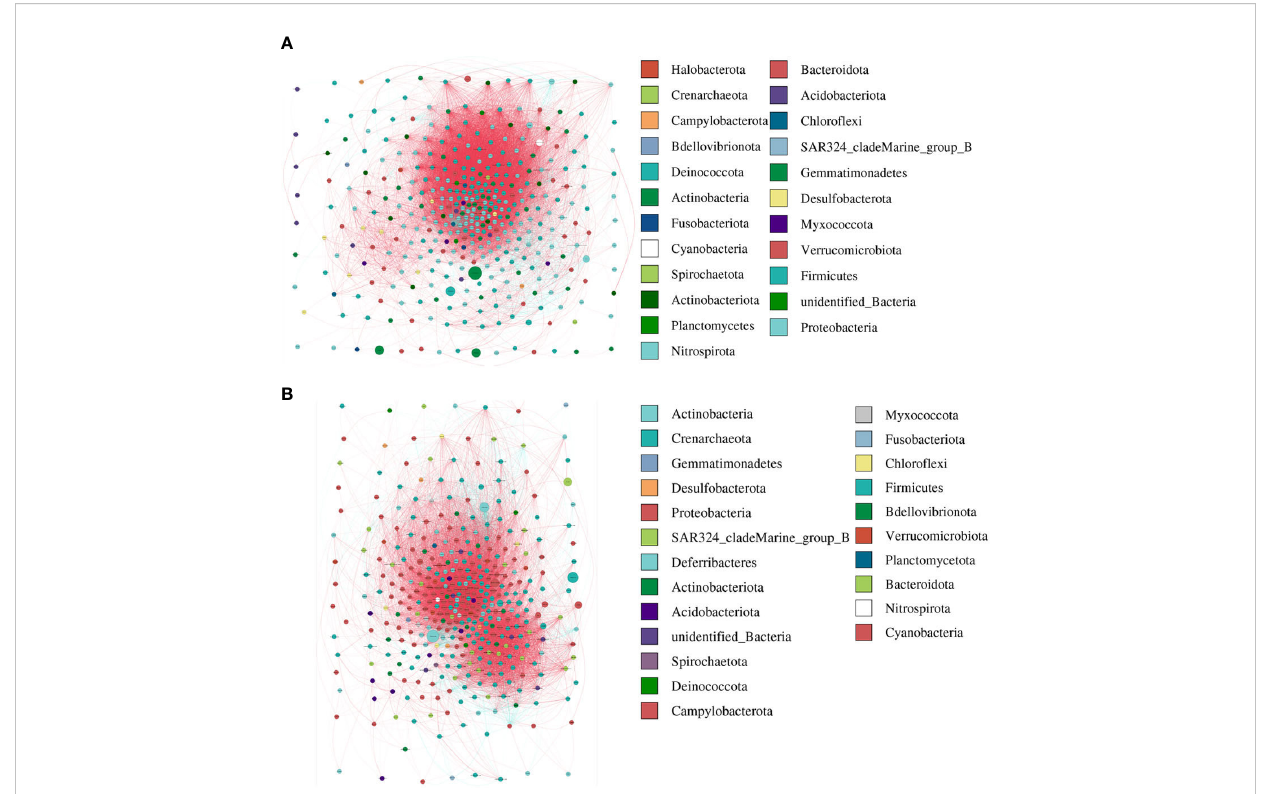
FIGURE 3 The network analysis between bacterial taxa for AR (A) and nAR (B) group. Different node color denotes varied phyla taxa and the weighted node size was based on the relative abundance. The weighted edges indicate the correlation coef fi